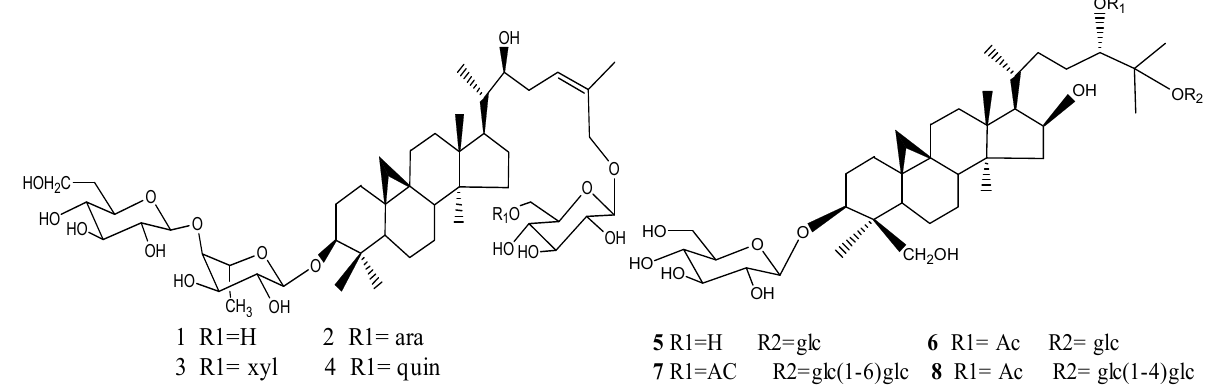
Figure 1. Structures of eight triterpenoids identified from Thalictrum fortunei .